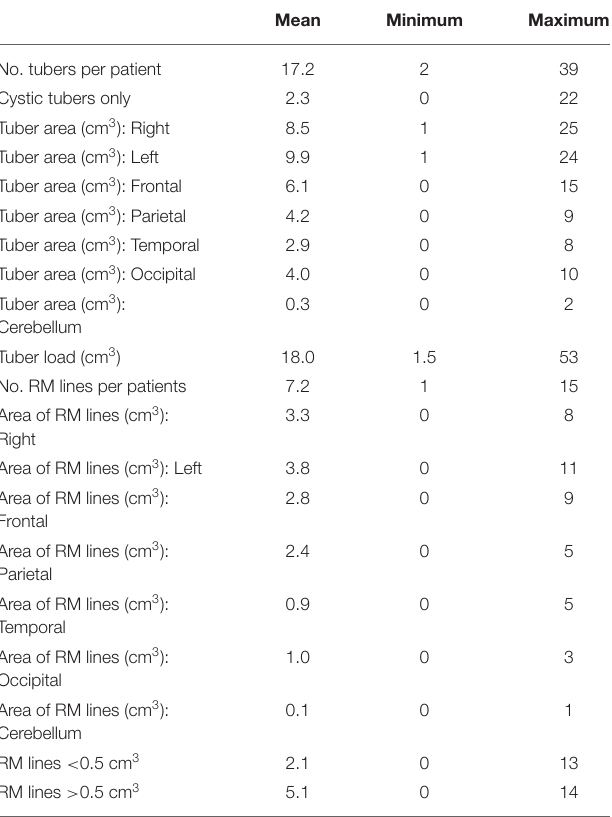
TABLE 2 | Characteristics of the tubers and radial migration (RM) lines in individuals with tuberous sclerosis complex. Mean Minimum